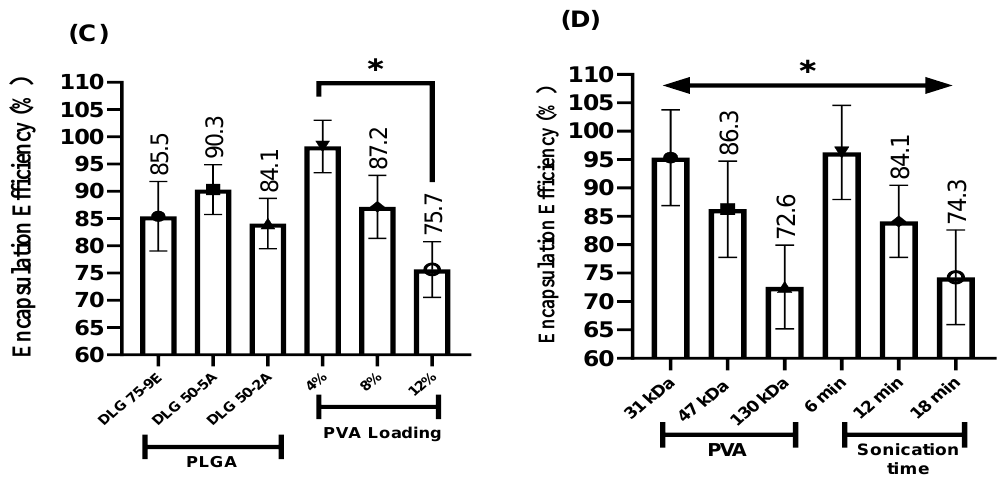
Figure 3. Encapsulation efficiency (C and D) of the 10% w/w 5-FU loaded PLGA nanoparticles. * indicates a significant